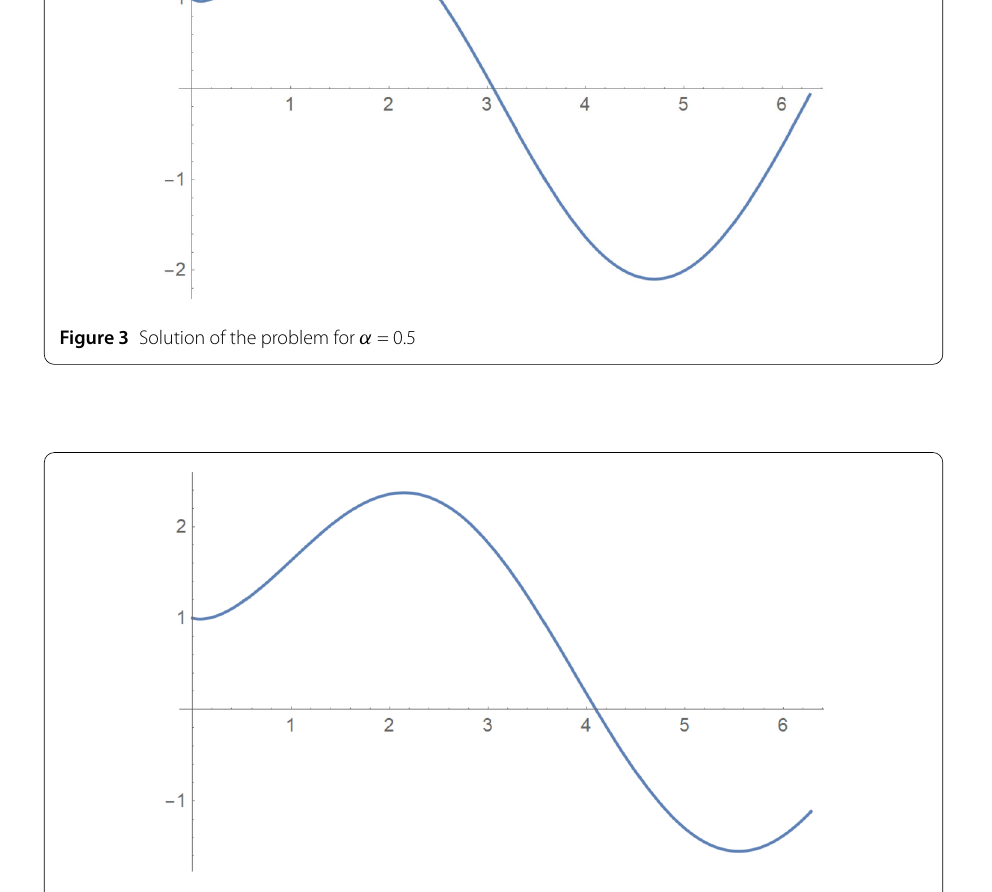
Figure 4 Solution of the problem for α = 0.7